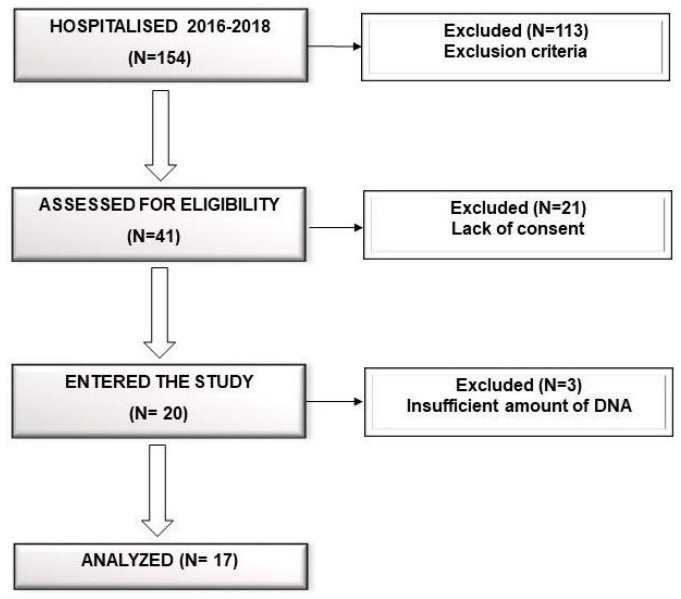
Figure 1. Study flow chart.